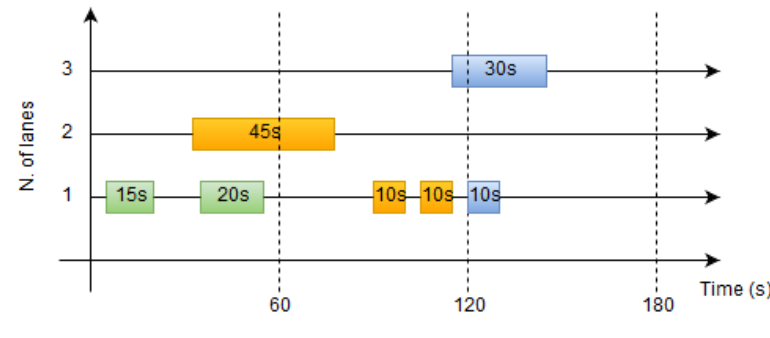
Figure 9. Window